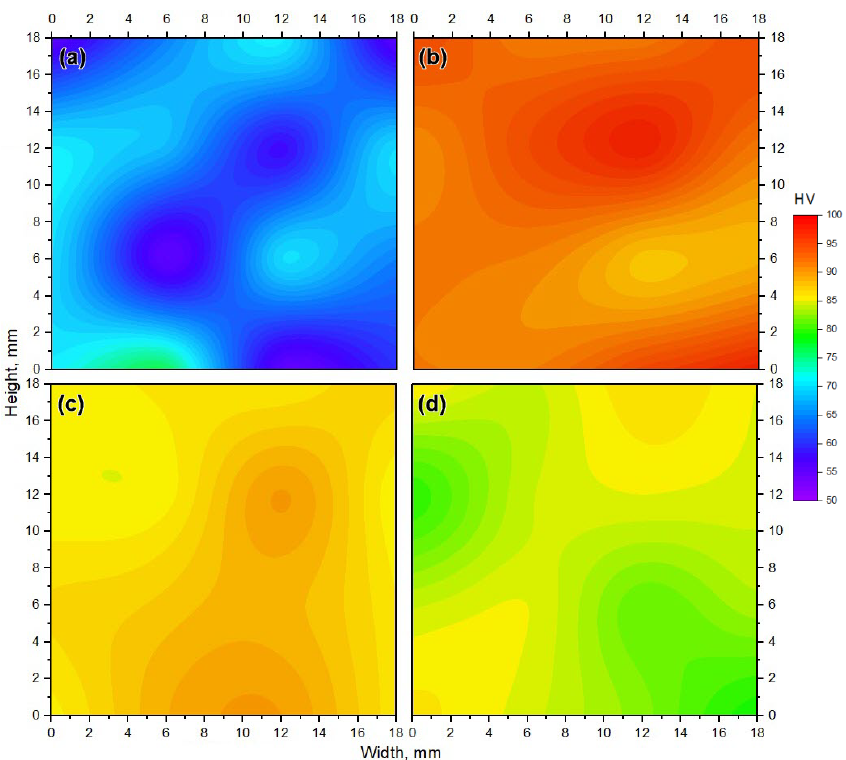
Figure 14 . Hardness distribution map for the as cast rod cross section ( a ), and the AMP fabricated parts using 1200 rpm and feeding rates of ( b ) 3 mm/min, ( c ) 4 mm/min and ( d ) 5 mm/min.